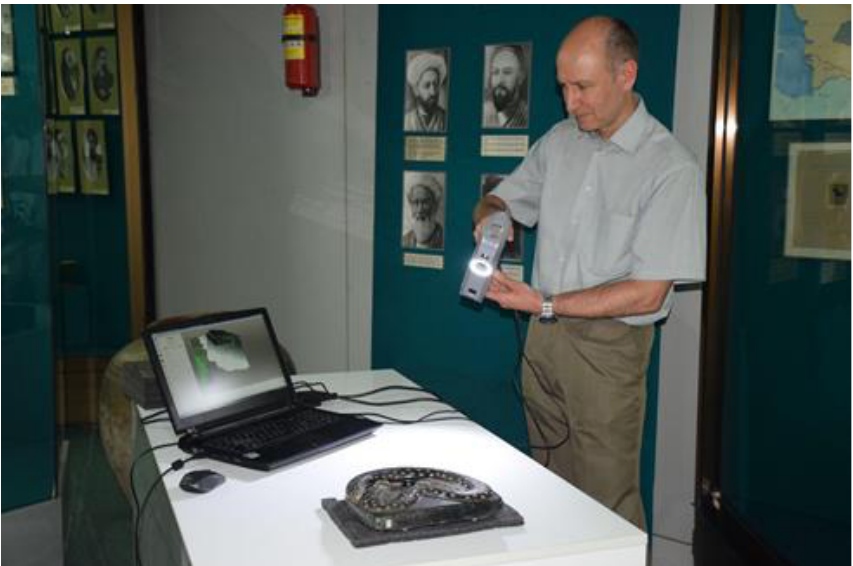
Figure 3. Scanning environment arrangement to scan the “Snake” figure.